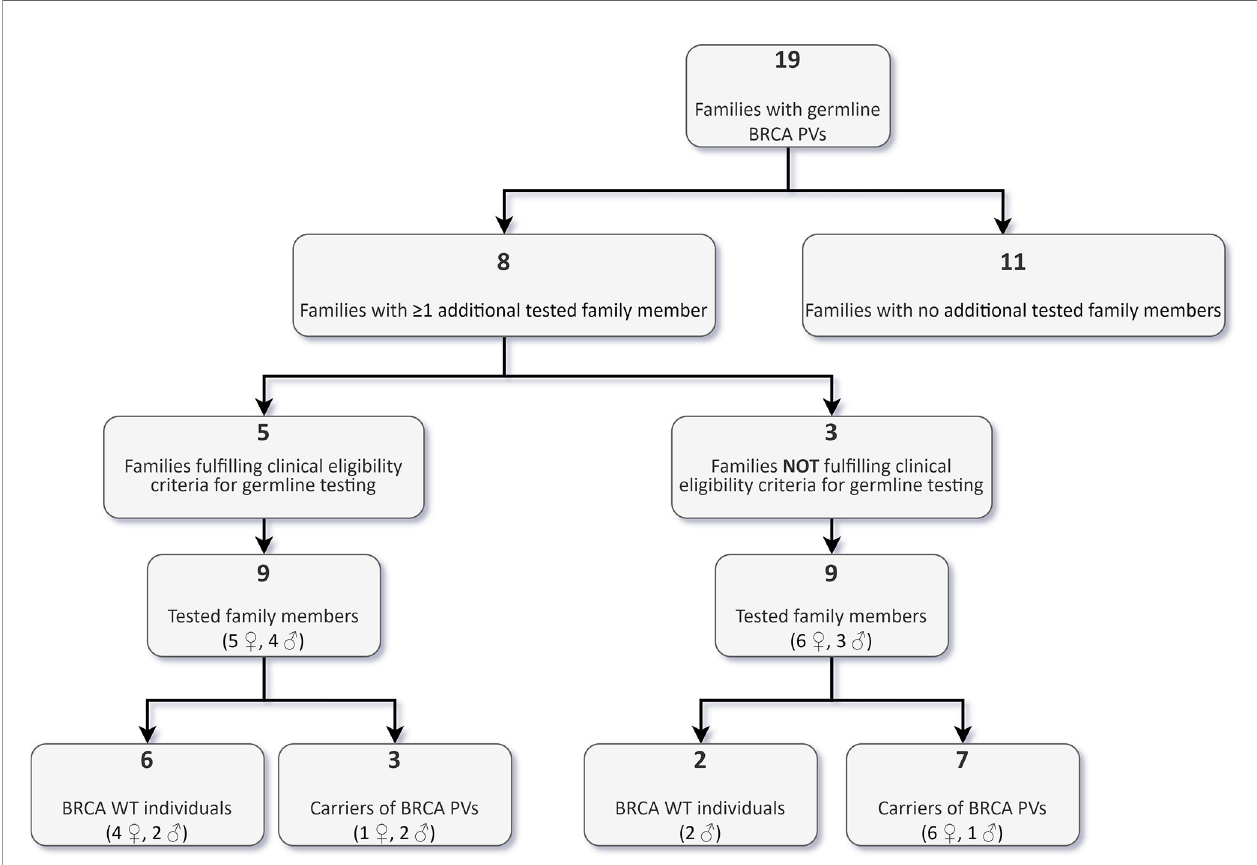
FIGURE 6 | Targeted analysis of BRCA pathogenic/likely pathogenic variants (PVs) in family members of carriers identi fi ed through tumour